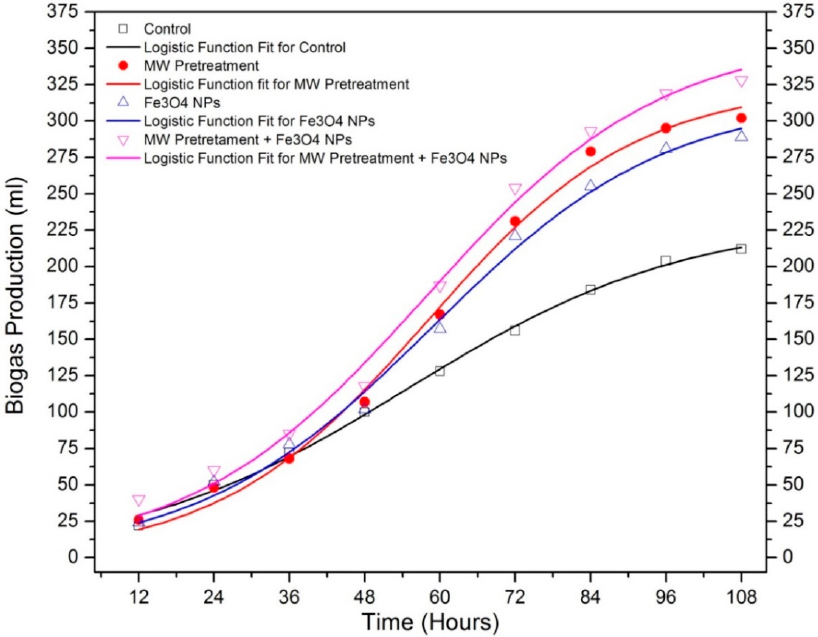
Figure 4. Modified Gompertz model fitting for experimental data.